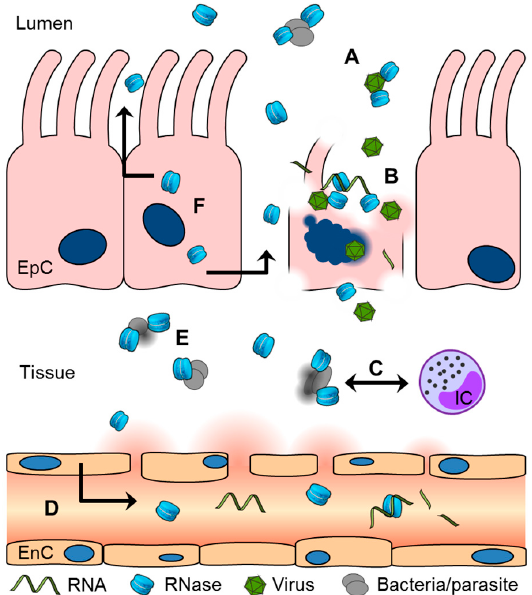
Figure 3. A schematic overview of the human canonical ribonucleases (RNases) in the host defence system. ( A , B ) RNases show antiviral activity and cytotoxic properties in mammalian cells and degrade RNA; ( C ) Cells of the immune system (immune cells, or ICs) secrete and are modulated by RNases; ( D , F ) Different mature cells secrete RNases, including endothelial (EnC) and epithelial (EpC) cells, for pericellular homeostasis; ( E ) Antimicrobial activity against bacteria, fungi and parasites has been demonstrated for RNases. RNA: Ribonucleic acid; HIV: Human immunodeficiency virus.